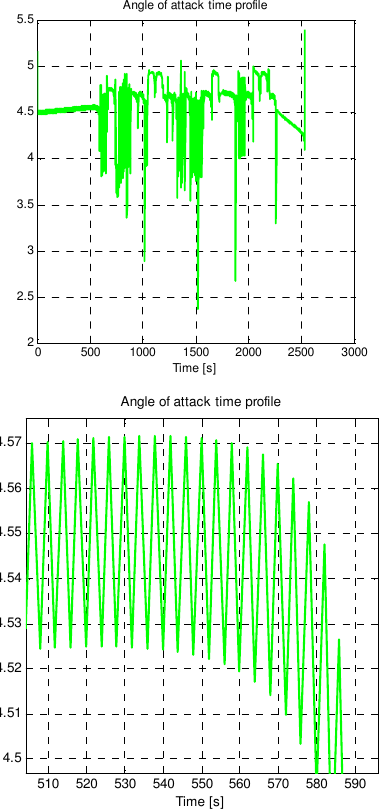
Fig 23. Angle of attack time profile (above) and zoomed magnified picture (below) when simulated with an integration timestep that is too large: 2 sec. The integrator does not capture important events and keeps oscillation around